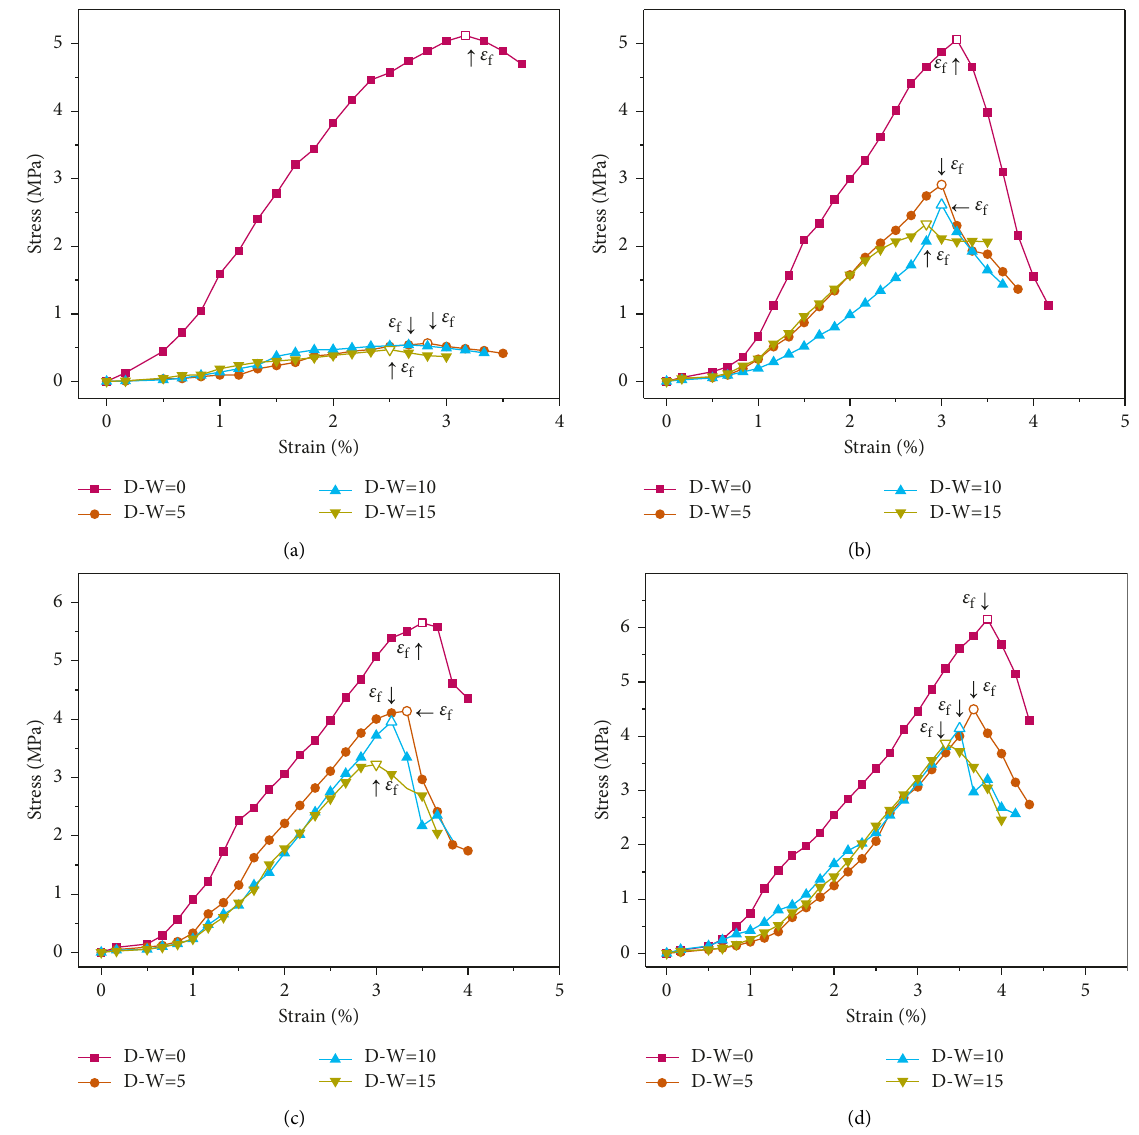
Figure 5: Stress-strain curve of sample. (a) 10% NHL. (b) 8% L+ 4% MK. (c) 8% L +8% MK. (d) 8% L+12%